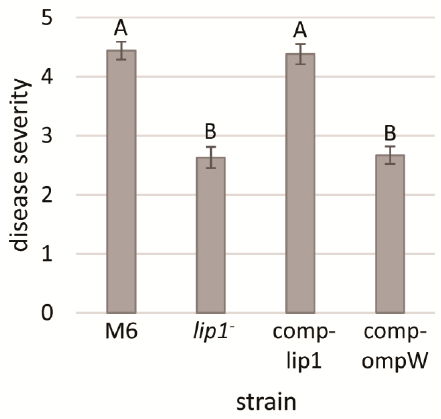
Figure 5. Seed transmission assays of melon inoculated with A. citrulli M6, the M6- lip1 - mutant, and M6- lip1 - carrying plasmid pBBR-MCS-5 expressing lip1 or ompW (M6-comp-lip1 and